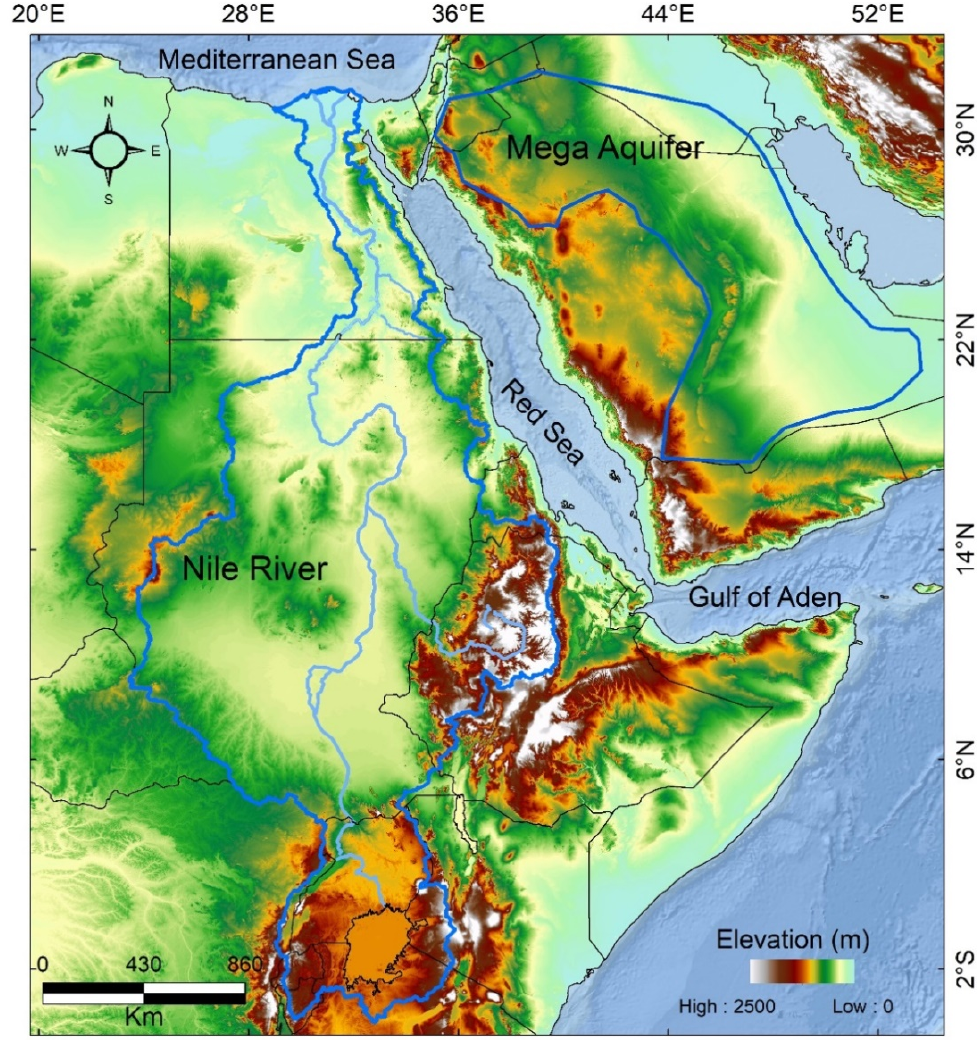
Figure 1. The study area represents the Nile River Basin in Africa and the Mega Aquifer in Asia (represented by blue polygons) shown on a topographic map.